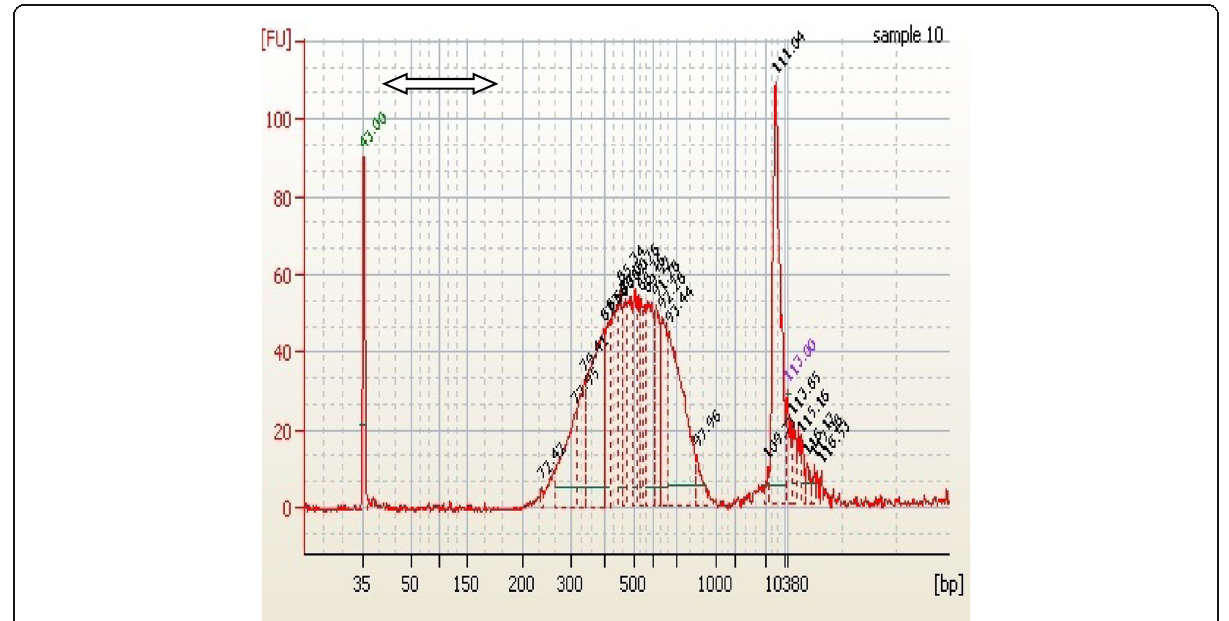
Fig. 7 Representative images indicating the size distribution and quality of cDNA library assessed on an Agilent bioanalyzerhigh sensitivity DNA chip. The cDNA produced a peak between 600 and 1200 bp as shown by the